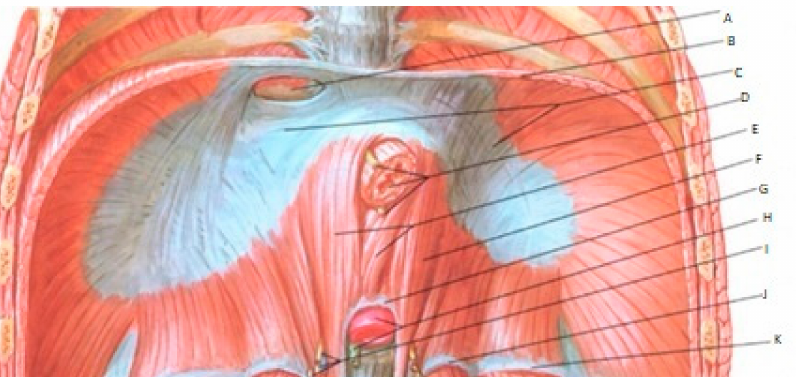
Figure 1. Anatomical relationship of the median arcuate ligament (MAL) to the diaphragm and the aorta. (A) Vena Caval Foramen; (B) Diaphragm; (C) Central Tendon of Diaphragm; (D) Esophagus and Vagus Nerves; (E) Right Crus of Diaphragm; (F) Left Crus of Diaphragm; (G) Median Arcuate Ligament; (H) Aorta and Thoracic Duct; (I) Thoracic Splanchnic Nerves and Azygos Vein; (J) Median Arcuate Ligament (medial lumbocostal arch); (K) Lateral Arcuate Ligament (lateral lumbocostal arch) (Reproduced from McCallum et al. [4] with permission from Practical